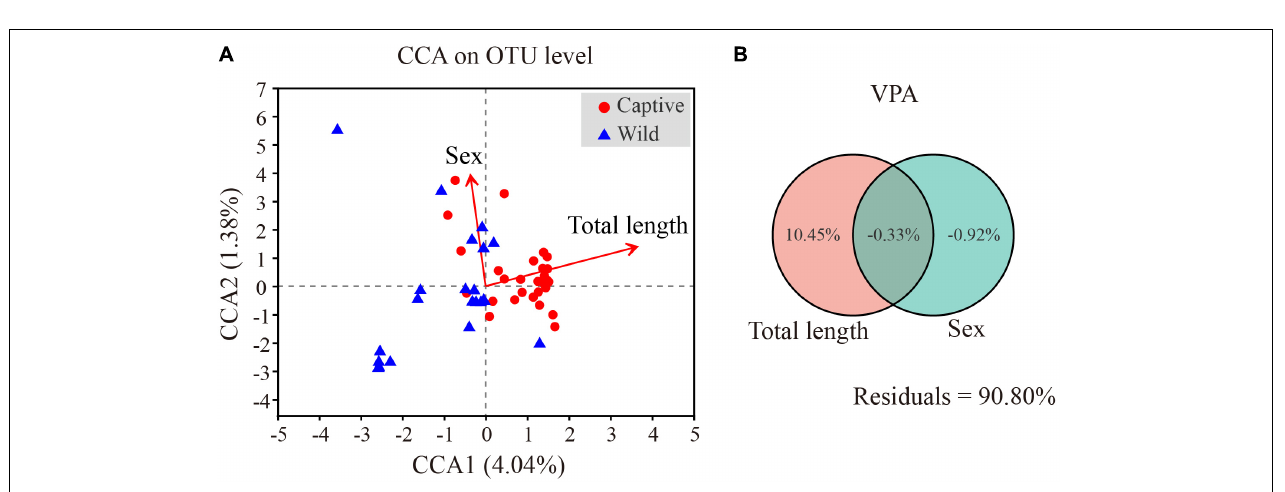
FIGURE 7 | Differences in the functional profiles in level 1 (A) and level 2 (B) pathways of the gut microbiota in Tokay gecko. The p value was represented by asterisks. Significant difference 0.01 < p < 0.05 was marked as “*”, 0.001 < p < 0.01 was marked as “**”, and p < 0.001 was marked as “***”.